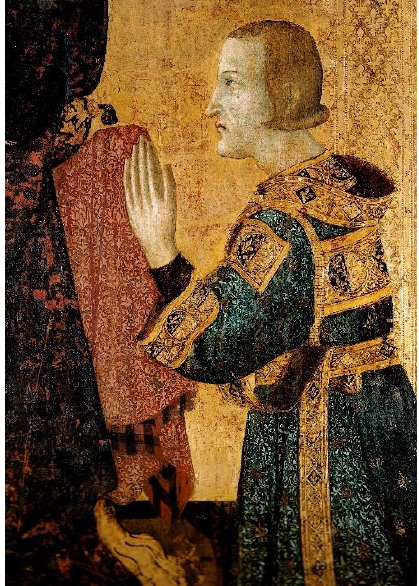
Figure 1. Simone Martini, Saint Louis of Toulouse crowning King Robert of Anjou , painting on wood, 1317–1319. Naples, Museo di Capodimonte. Detail of Robert’s face. Source: public domain image.